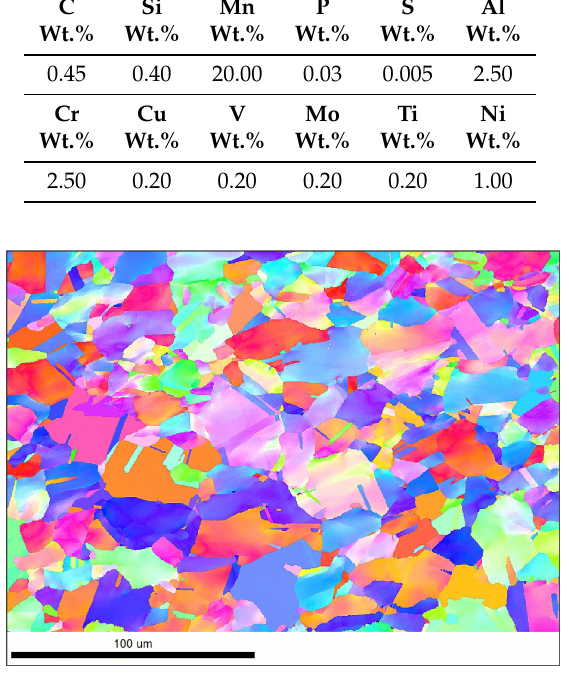
Figure 1. Inverse Pole Figure (IPF) map of the as-received condition showing a homogenous microstructure with recrystallization twins and an average grain size of about 20µm.